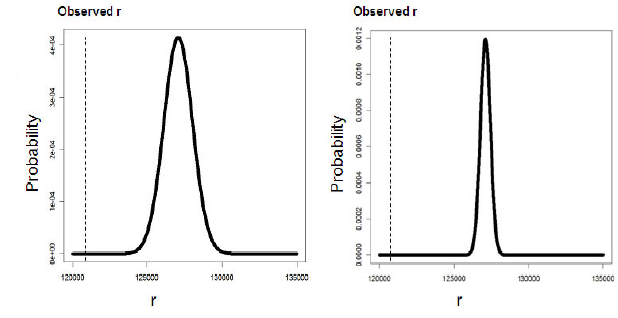
Fig. 8. a) Poisson approximation; b) Censored binomial approxi- mation; with p = 1 052 420 and L = 135